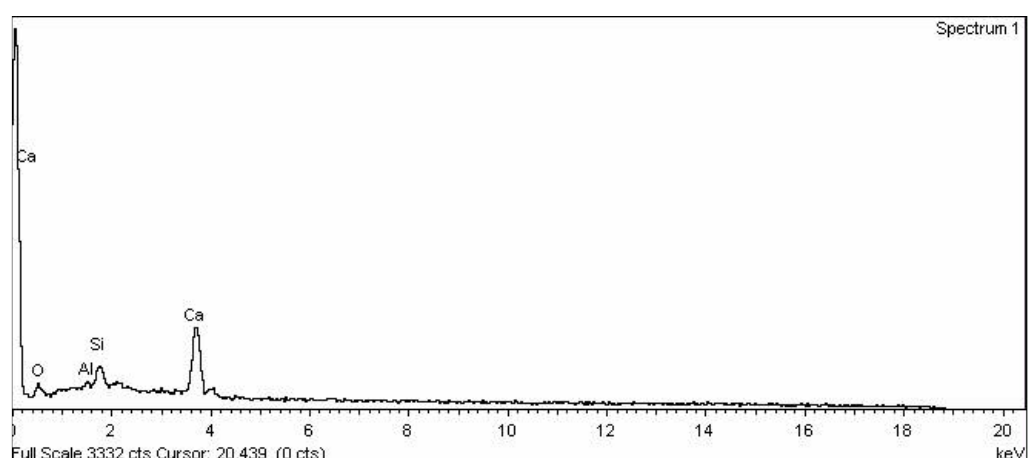
Figure 9. EDX analysis of concrete powder with 0% soap solution and RHA.